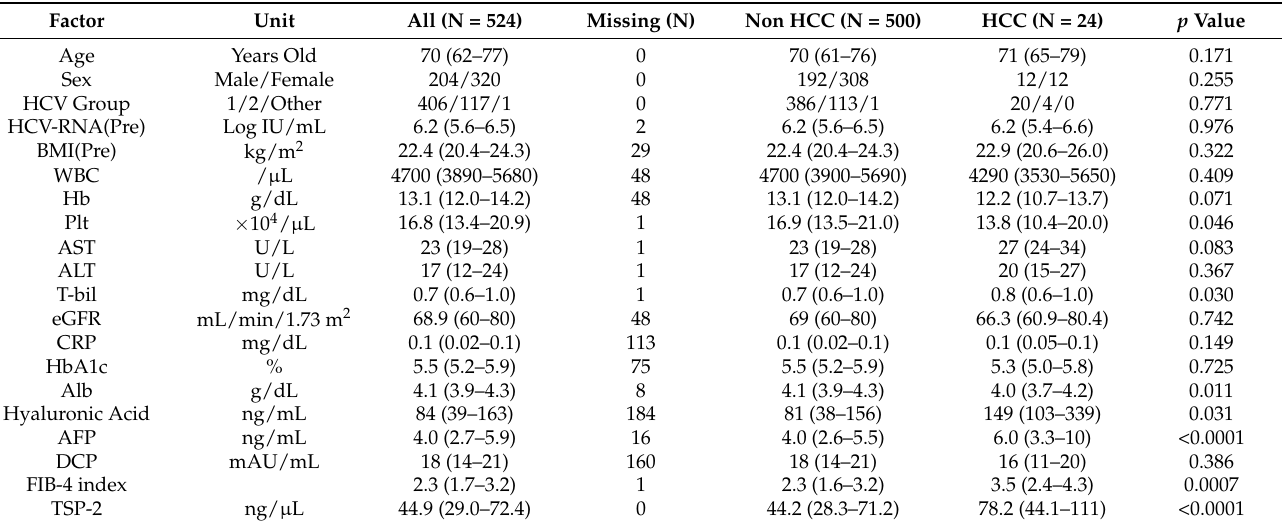
Figure 1. Serum TSP-2 levels can be used to identify CHC patients who have a high risk of HCC development after HCV elimination by DAA treatment. ( A ) Kaplan–Meier curve for HCC occurrence in the derivation cohort. ( B ) Serum TSP-2 levels in the HCC+ group and HCC − group in the derivation cohort. ( C ) ROC curve of TSP-2 for HCC occurrence in the derivation cohort. ( D ) Kaplan– Meier curves for the occurrence of HCC in patients in the derivation cohort divided by the TSP-2 Youden index level of 86.954 ng/µL. Table 1. Characteristics of patients in the derivation